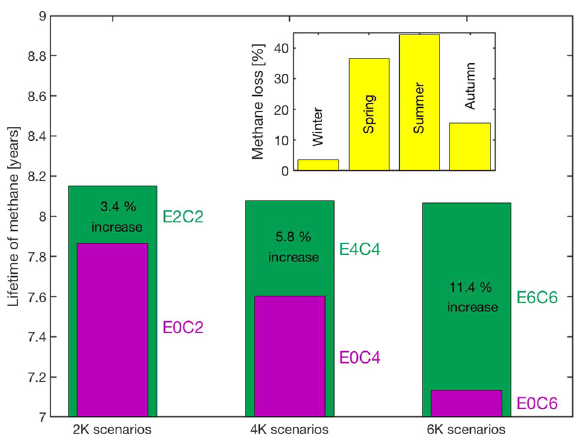
Fig. 4 Methane lifetime increase. The methane lifetime for the different scenarios. The numbers inside the bars present the percentage changes in the methane lifetime between the different scenarios (the number in bar one present the difference of methane lifetime comparing E2C2 and E0C2). The inset plot shows the seasonal percentage loss of methane averaged over all scenarios. The scenario abbreviations EXCX stands for E = emission, C = chemistry and X = temperature increase in the related (Supplementary Fig. 6). In the two scenarios E0C6 and E6C6, TM5- Chem has much lower impact on OH concentrations than SOSAA.